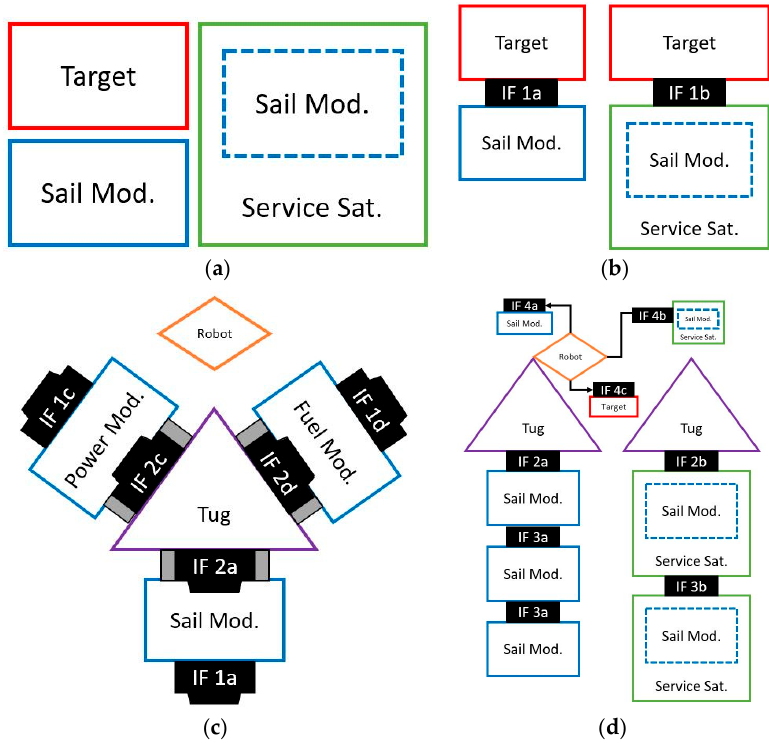
Figure 4. Main actors and interfaces involved in (Drag) Sail Modules operated from Space Tugs: ( a ) Target satellite, (Drag) Sail Module and Service satellite embedding or not a (Drag) Sail Module; ( b ) possible interfaces/attachments providing a (Drag) Sail Module to the Target satellite; ( c ) the Space